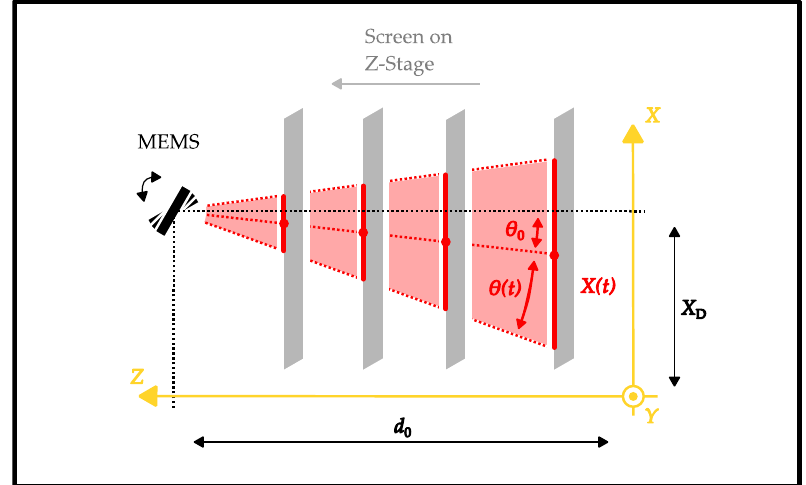
Figure 4. Concept of the ray trace shifting technique